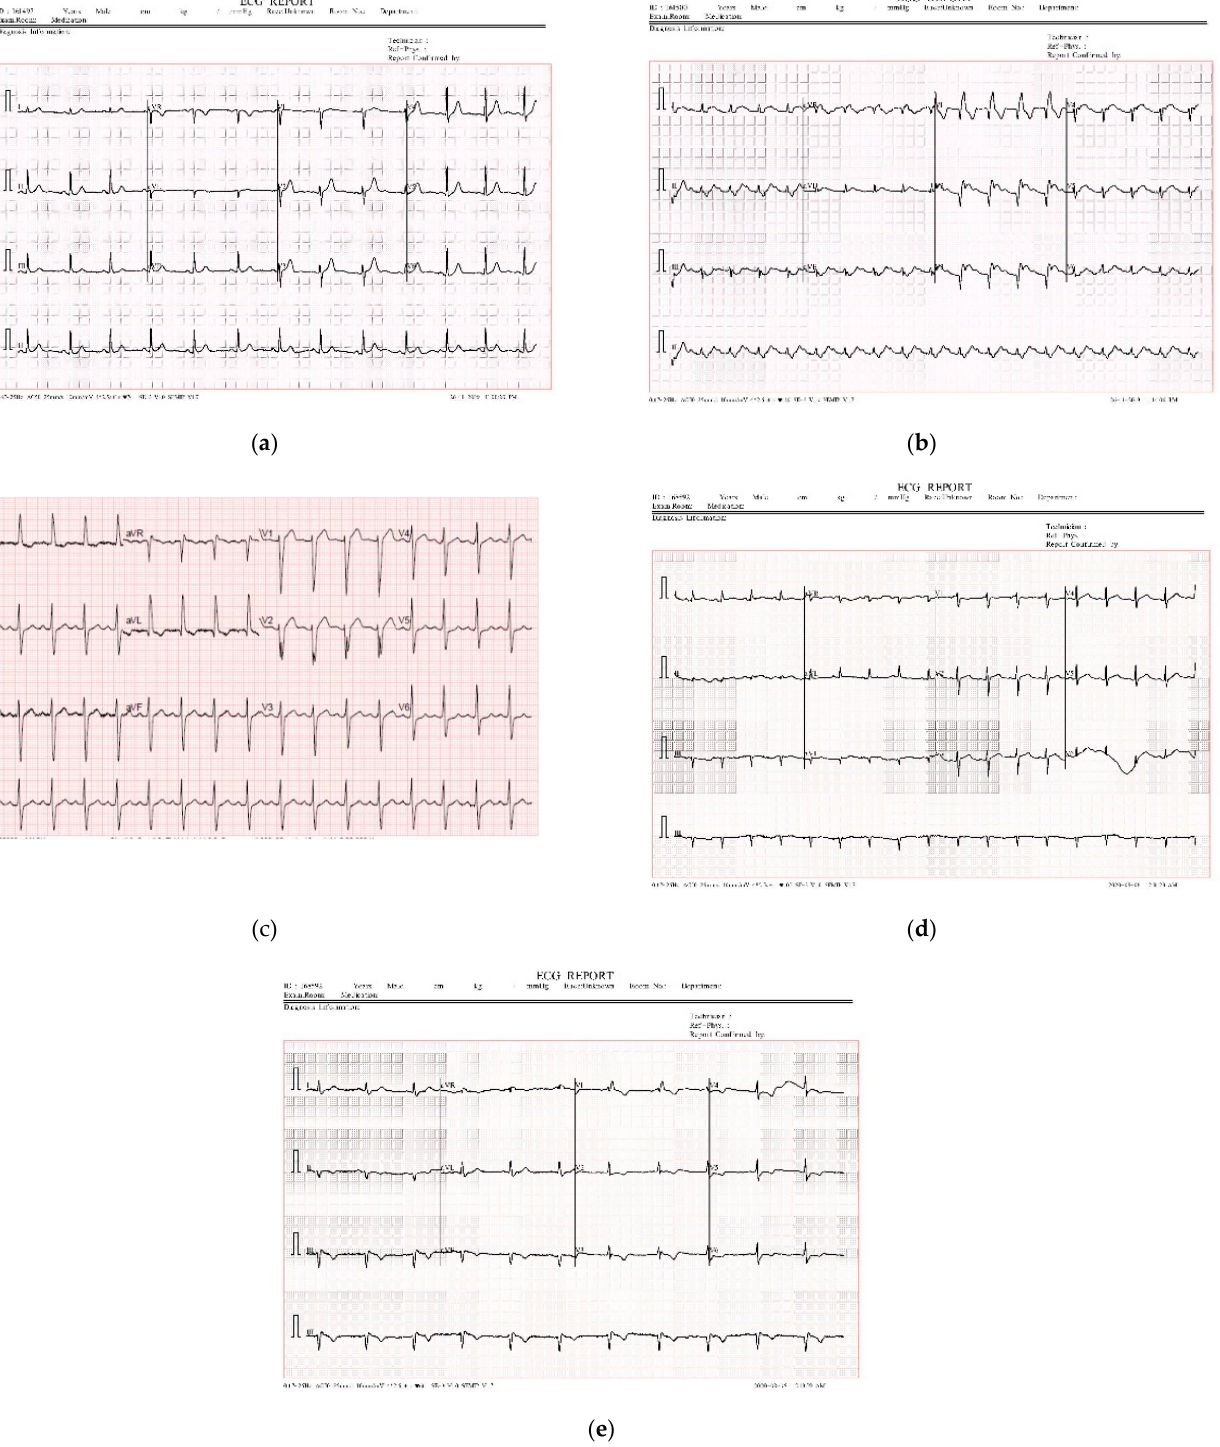
Figure 2. COVID and Cardiac disease dataset containing paper-based ECG signal images of